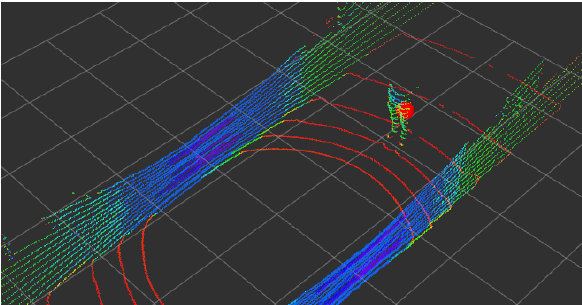
Figure 5. People positions in the LiDAR reference frame. The red marker represent the center of the three dimensional bounding box.